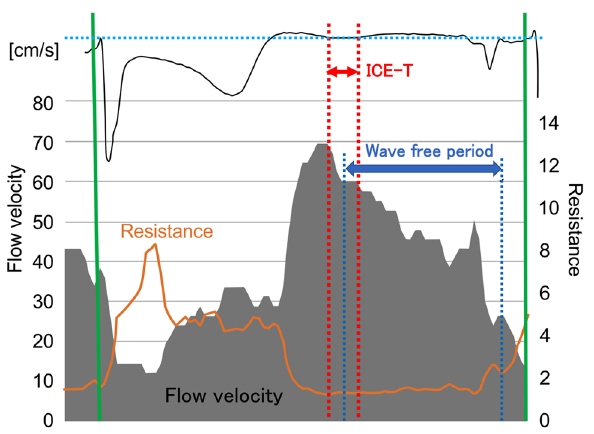
Figure 3. An example of flow velocity, resistance, and intracoronary electrocardiogram recorded in the left anterior descending coronary artery under hyperemia. The flow velocity decreased sharply after reaching a high peak flow. The isoelectric line of the intracoronary electrocardiogram detected the phase immediately after the peak flow velocity. The flow velocity varied greatly during the